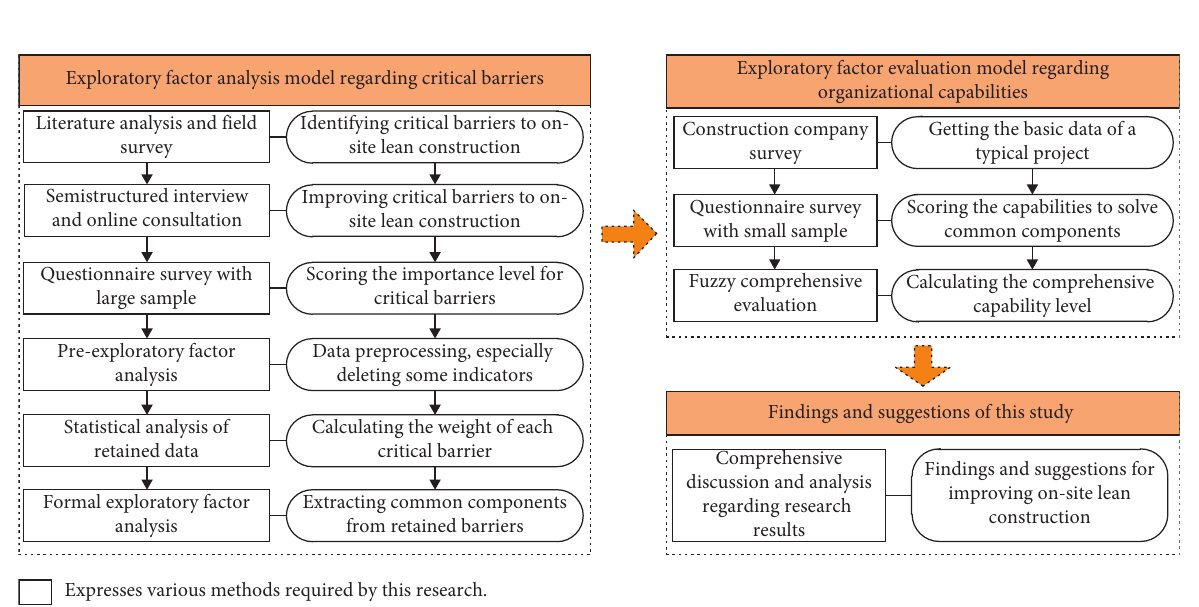
Figure 1: Research methodology based on multimethod collaboration.